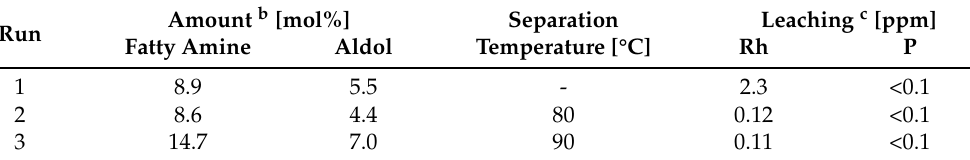
Table 3. Catalyst recycling for the reductive amination of undecanal with diethylamine a . Amount b [mol%] Separation Leaching c [ppm] Run Fatty Amine Aldol Temperature [°C] Rh P 1 8.9